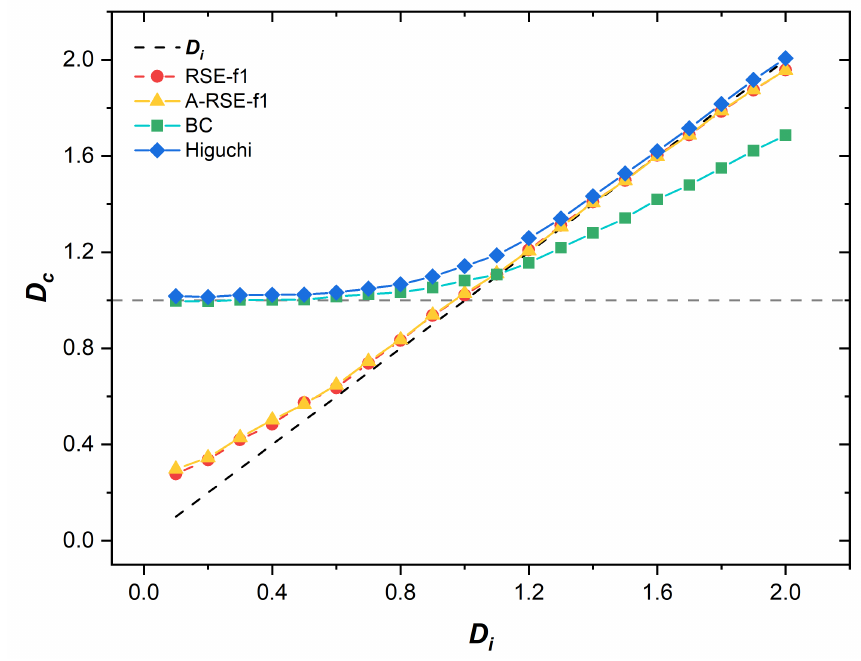
Figure 5. Comparision of the ideal dimension ( D i ) and the calculated dimension ( D c ) by RSE-f1, A-RSE-f1 Higuchi, and BC algorithms.